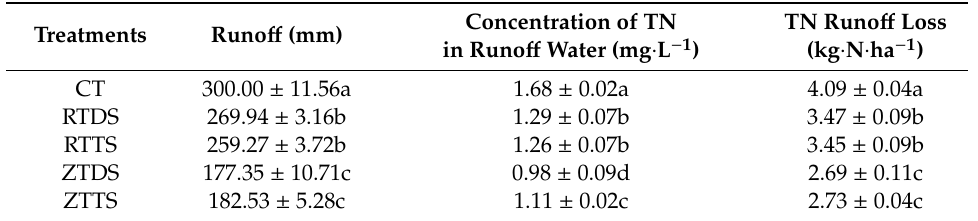
Table 2. E ff ect of tillage methods on N loss.